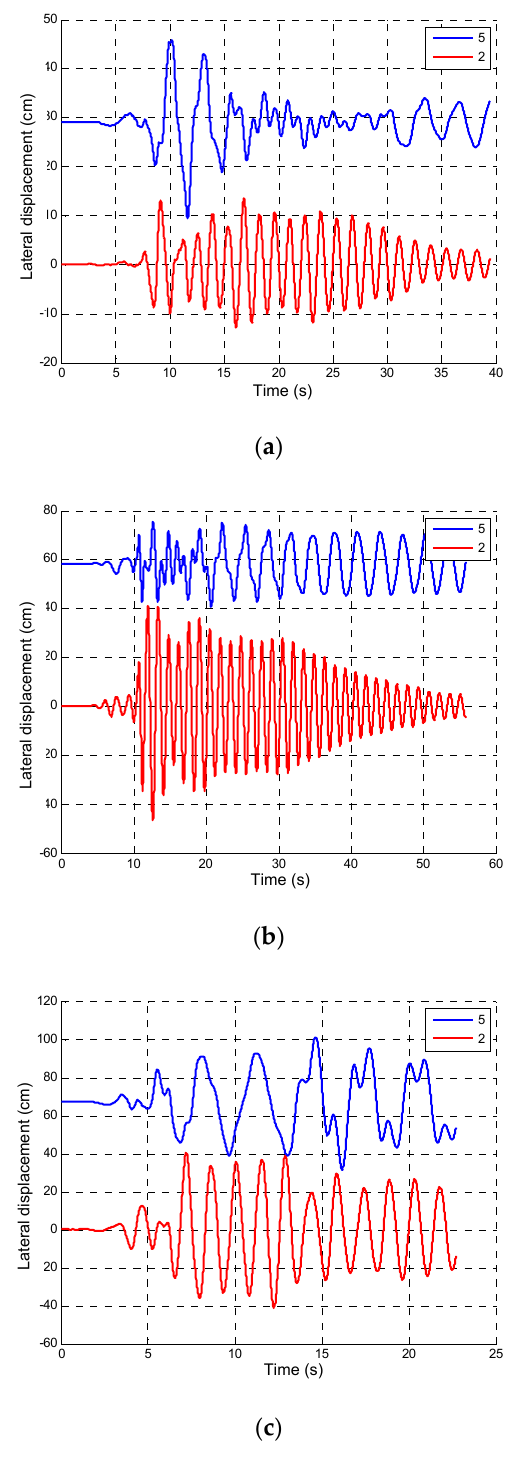
Figure 5. Examples of the results of the verification analysis for a two-story building located close to a five-story structure (arrangement 2-5) under three earthquake records: ( a ) Imperial Valley earthquake, seismic gap: 29 cm, ( b ) Kocaeli earthquake, seismic gap: 58 cm, ( c ) Tabas earthquake, seismic gap: 67 cm.